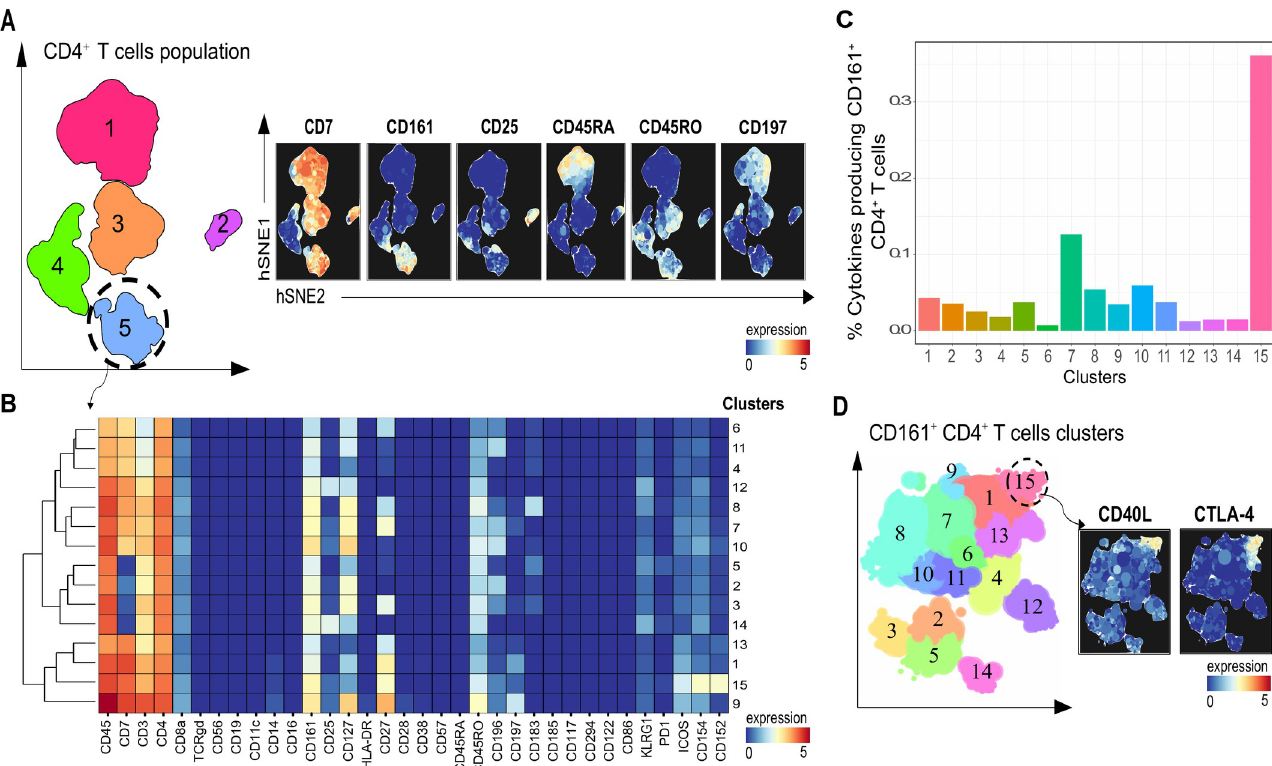
Fig 3. Na-GST-1 specific cell phenotype. (A) HSNE embedding of 1.1 million CD4 + T cells at day 194 in Na-GST-1 high dose (100 μ g) recipients (n = 3), depicting 5 subsets. The colour represents arcsin5- transformed expression values of indicated markers. (B) Heatmap summarizing the median expression of markers present on identified clusters of CD4 + CD161 + T cell subset (subset 5). The colours are the same as for the HSNE plots in A. (C) Bar plots depicting the frequency of clusters producing cytokines relative to CD4 + CD161 + T cells. (D) Cluster partitioning of CD4 + CD161 + T cells and HSNE plots highlighting cluster 15, which has an increased expression of both CD40-L and